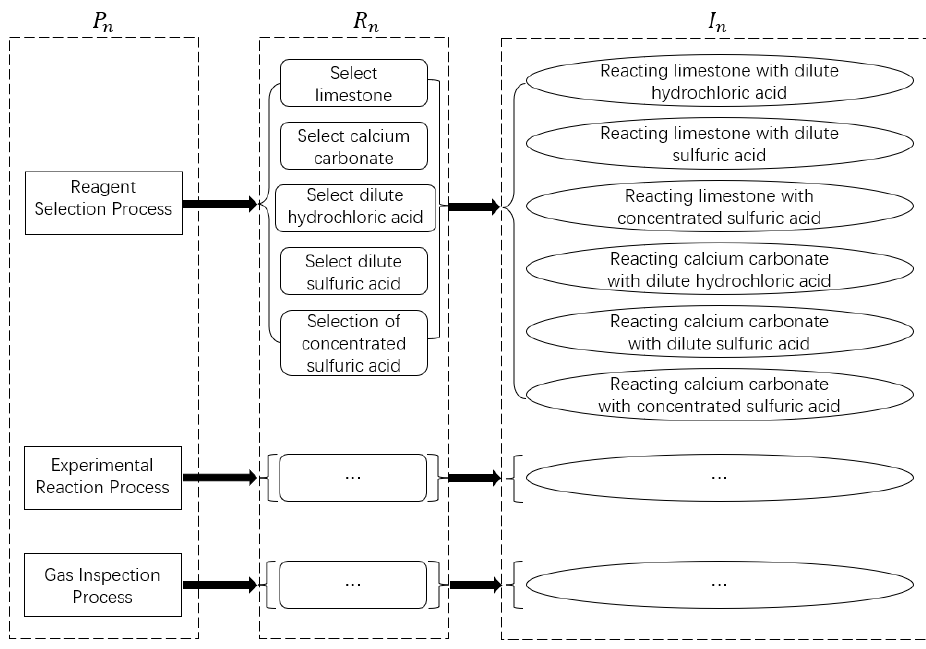
Figure 3. Behavior–intent mapping